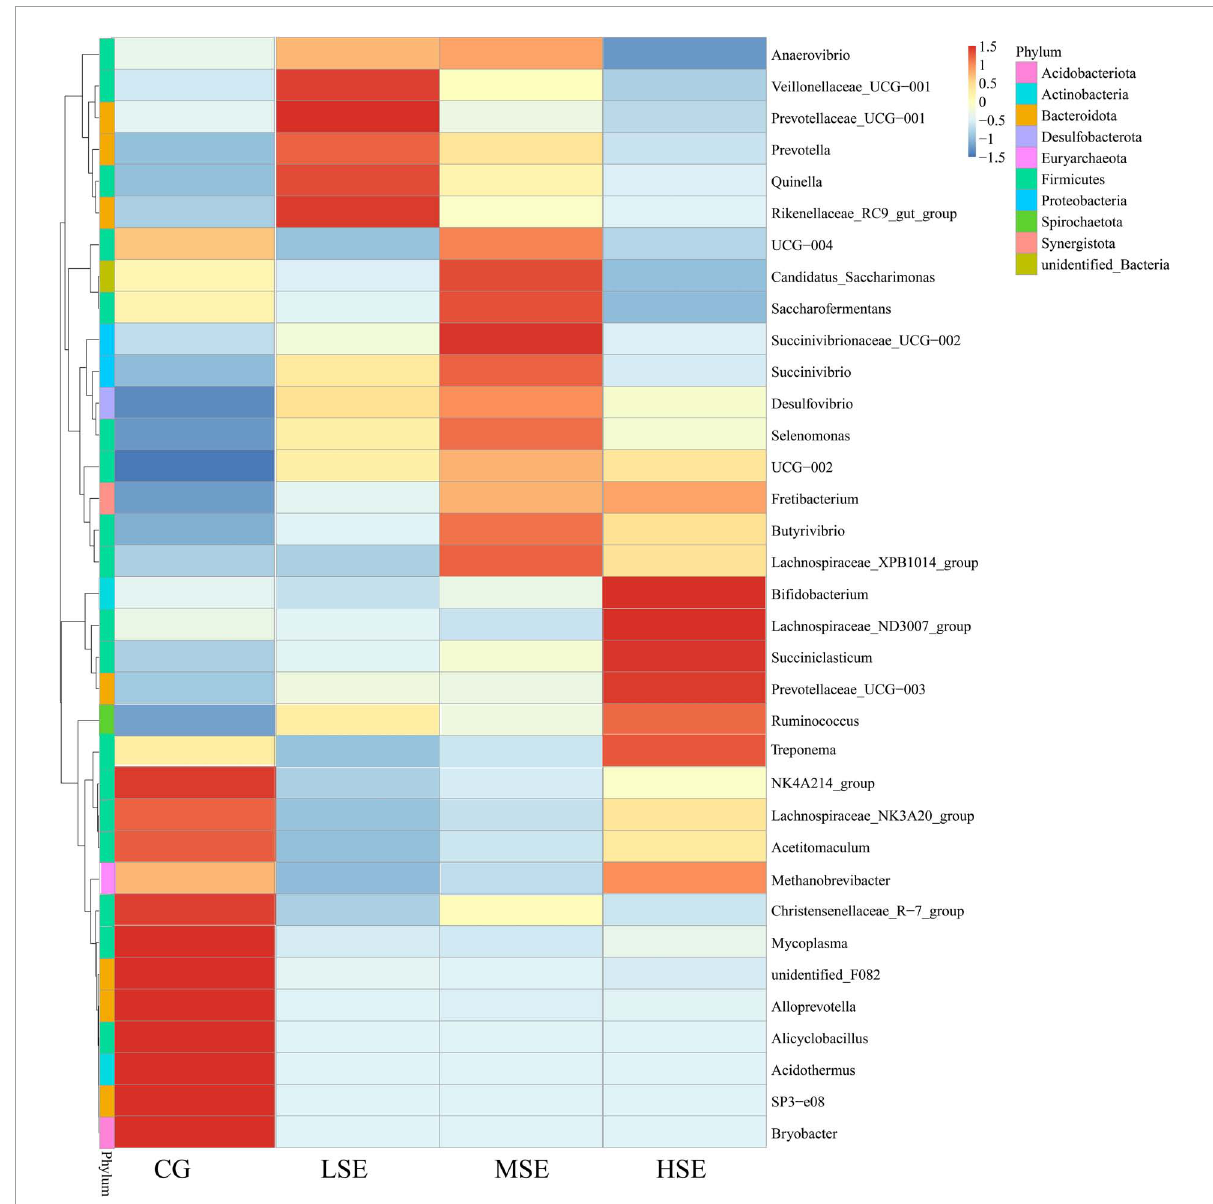
FIGURE6 Heatmap analysis of top 35 bacterial genera as determined by the relative abundance of taxonomic genera levels. The vertical axis is sample information, the horizontal axis is species annotation information. On the left is the species clustering tree. The heatmap in the middle corresponds to the standardized Z-score of the relative abundance of each row